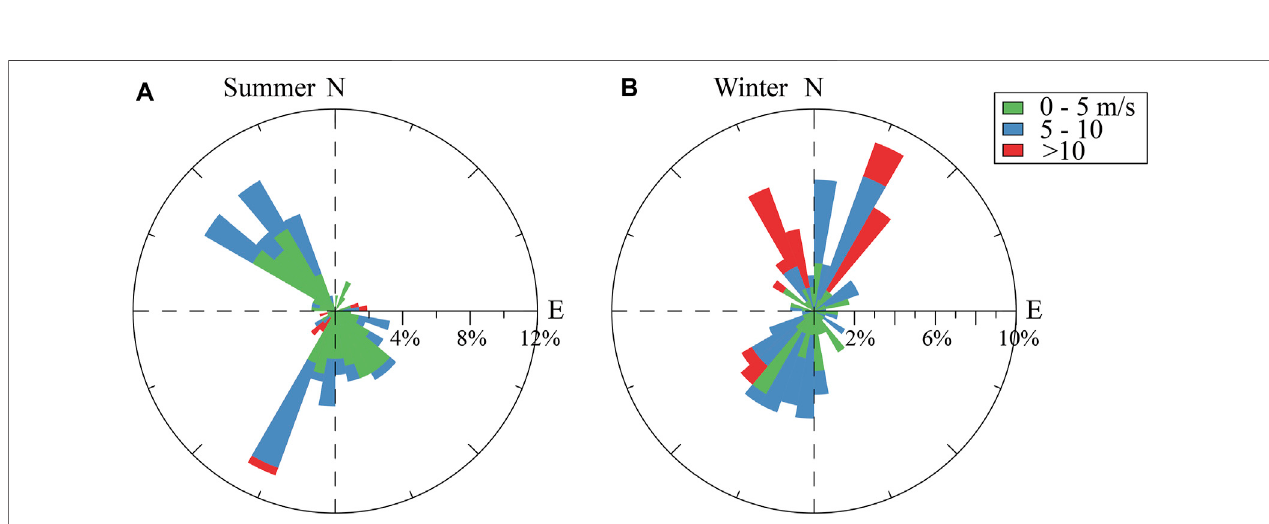
FIGURE 5 | Rose diagrams of hourly averaged wind frequencies during (A) summer and (B) winter observations at S3. The greyscale indicates the categories of wind speed (m/s).